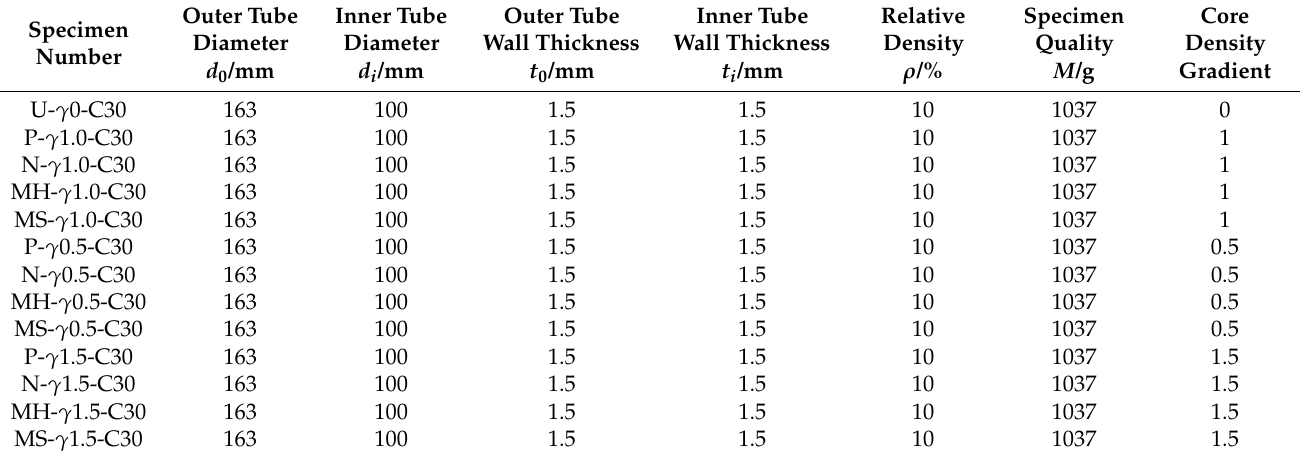
Table 3. Geometric parameters of aluminum foam sandwich tubes with different gradients.